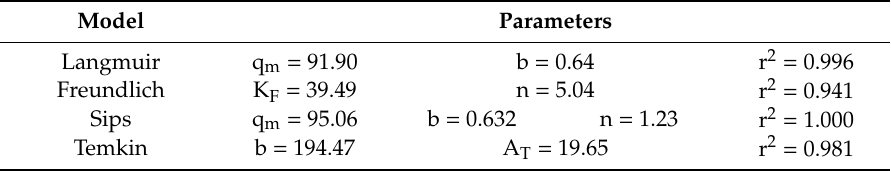
Table 5. Adjustment results of the experimental data to the four selected isotherm